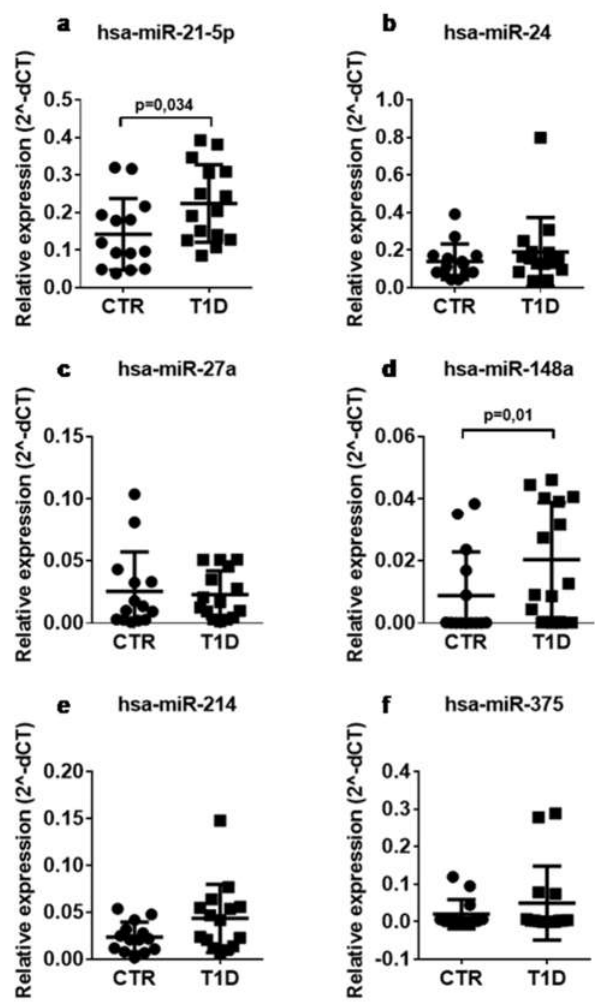
Figure 1. The expression of hsa-miR-148a and miR-21-5p is increased in the serum of patients with T1D. Single assay RT-qPCR validation of miR-21-5p ( a ), miR-24 ( b ), miR-27a ( c ), miR-148a ( d ), miR-214 ( e ), and miR-375 ( f ) in n = 14 non-diabetic and n = 15 T1D patients. Data are reported as mean ± SD of normalized 2 − ∆ CT values. Statistics using Mann–Whitney U test, p < 0.05.